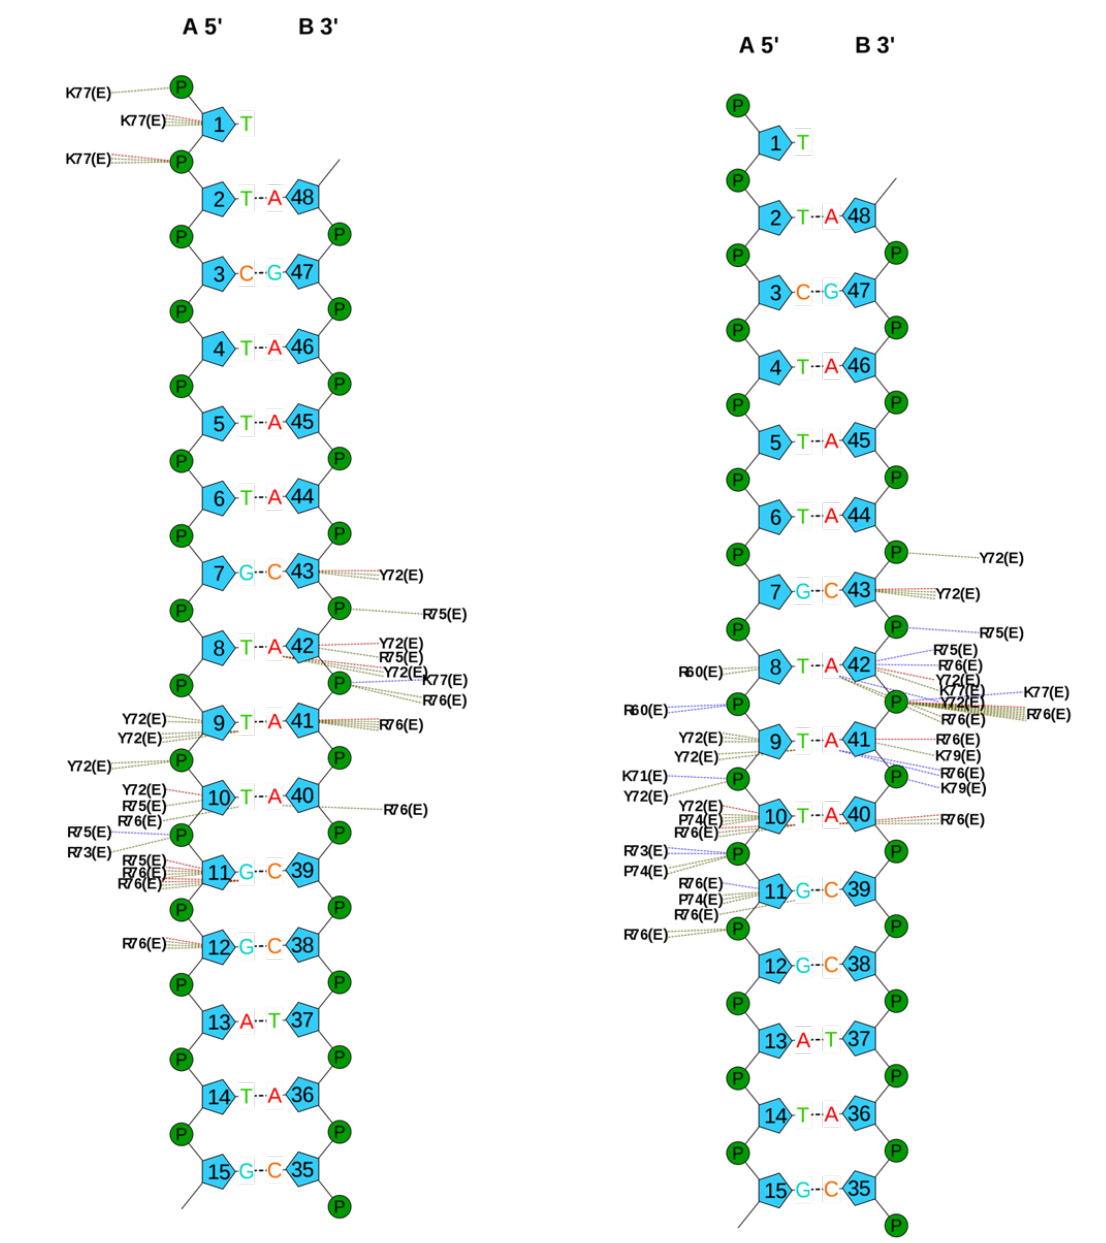
Figure 7. Scheme of the interactions with DNA of residues in SOX2 (chain E) corresponding to the iPep in PDB entry 1GT0 ( left ) and a representative snapshot from the MD simulation of SOX2/OCT4/FGF4-enhancer ( right ). Hydrogen bonds, ionic interactions, and vdW interactions are shown by blue, brown, and green dotted lines. The plots were obtained using the NuProPlot [41]. Bridging water molecules are not shown. Residues Lys57 to Tyr70 are involved in inter-residue interactions in the SOX2 C-terminal helix and do not interact with DNA in the starting structure whereas Arg60 forms an ionic interaction with DNA (DT8 and DT9). Numbering is based on the SOX2 crystal structure.